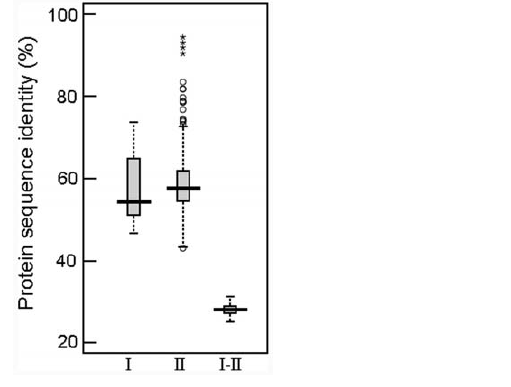
Figure 2. Pairwise sequence identity of full-length TPS proteins. I and II represent pairwise sequence identities of classes I and II TPS proteins, respectively. I–II represent pairwise sequence identities between class I and II TPS proteins. The boxplot shows the median (black line), interquartile range (box), and maximum and minimum scores (whiskers) for each data set. Outliers are shown as circles, and asterisks are outside of the whiskers.